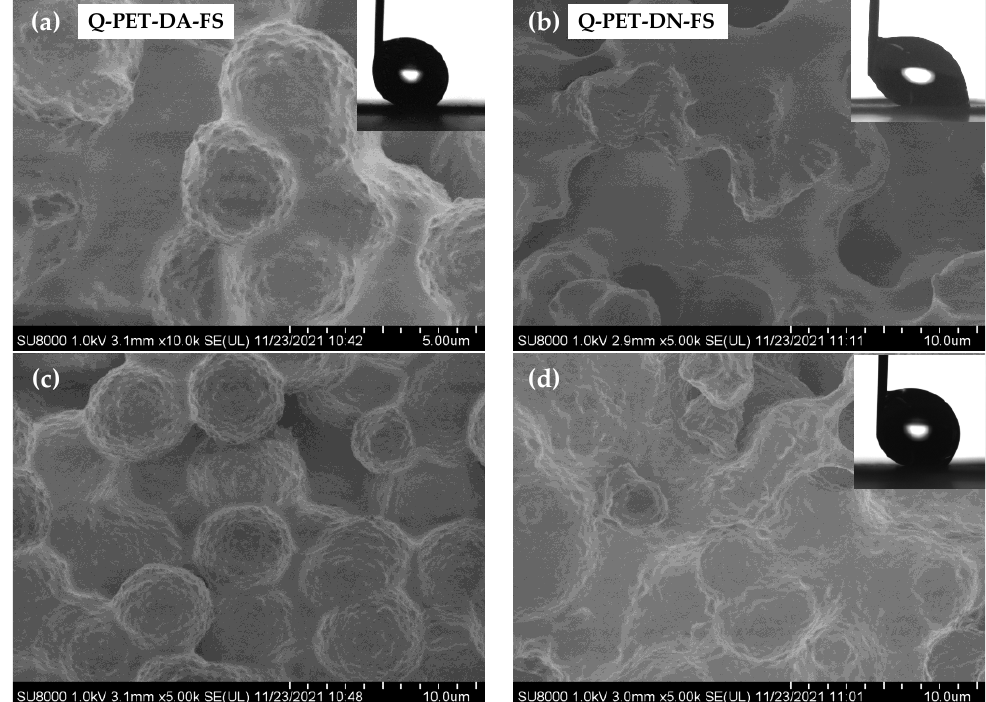
Figure 8. SEM images of samples Q-PET-DA-FS ( a , c ) and Q-PET-DN-FS ( b , d ) on the surface at 5000× ( a , b , d ) and 10,000× ( c ) and images visualizing the Δθw values of these surfaces.